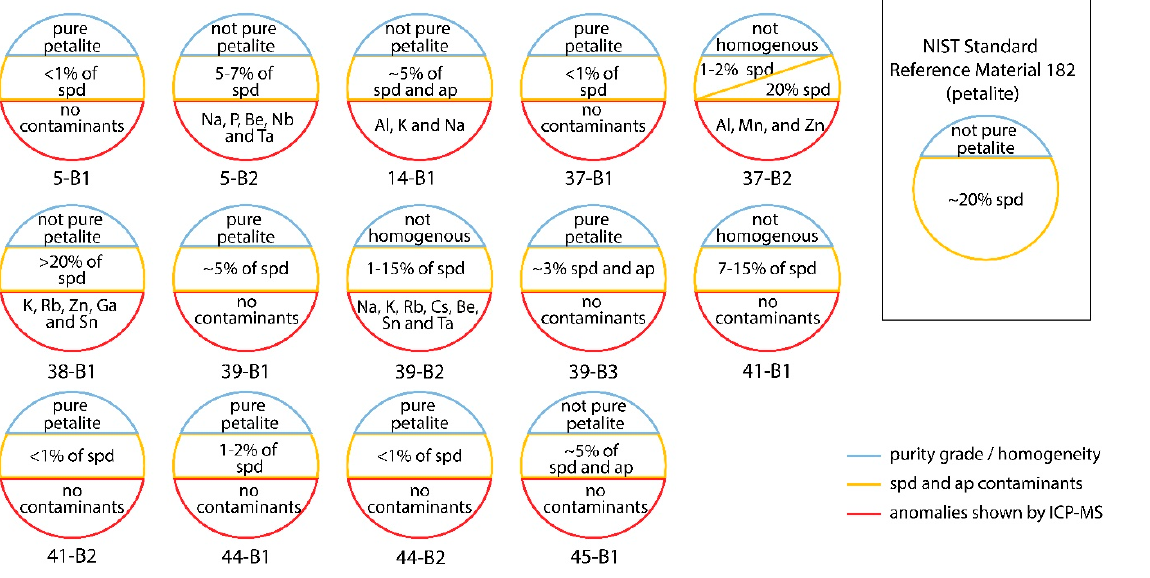
Figure 12. Summarization of the cold cathodoluminescence (CL) observations, based on visual percentage estimation of petalite, spodumene (spd) and apatite (ap). Since the strong luminescence of spd and ap usually creates a halo of light around it (making them seem larger), the results from the visual estimation are probably overestimated.